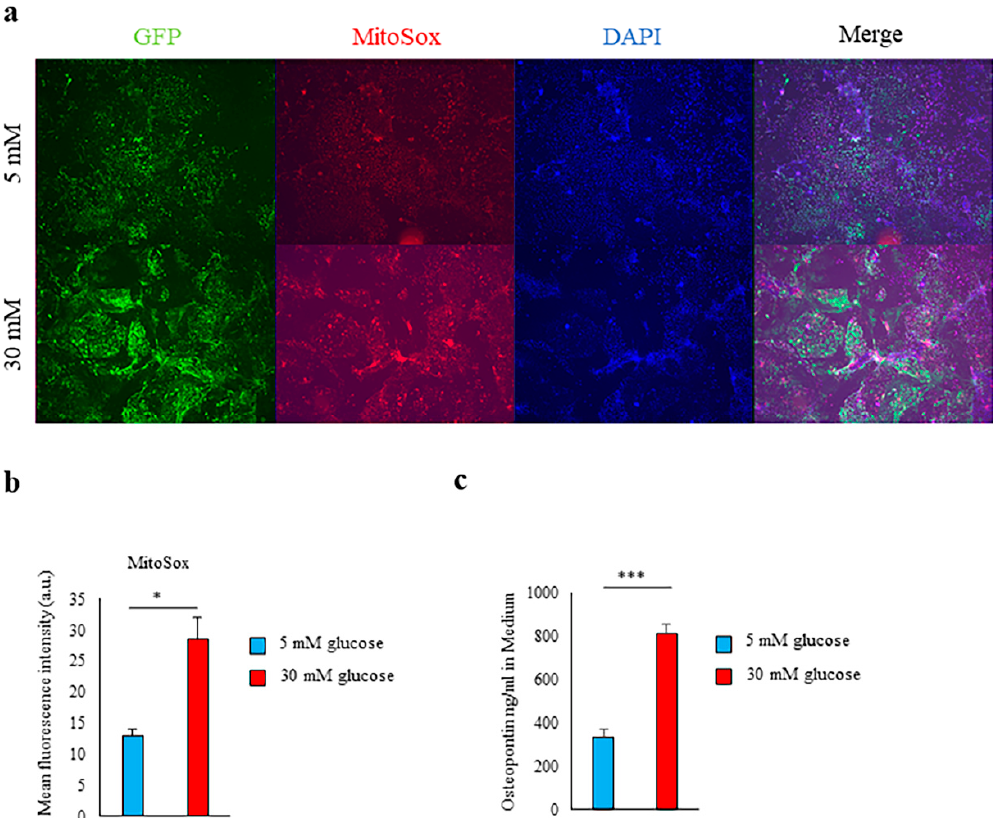
Figure 1. Hyperglycemia induced Spp1 transcriptional activity in renal proximal tubular epithelial cells. ( a–c ) Primary culture of proximal tubular epithelial cells (PTEC) derived from enhanced green fluorescent protein (EGFP)- Spp1 knock-in reporter mice. PTEC were cultured in 5 mM or 30 mM glucose conditions for 7 days. ( a ) Microscopic analysis of fluorescence of 4 (cid:48) ,6-diamidino-2-phenylindole (DAPI) and MitoSOX staining and of EGFP- Spp1 expression. ( b ) Mean fluorescence intensity of MitoSox in PTEC ( n = 3 per group). ( c ) Osteopontin (OPN) in the culture supernatants was assessed by enzyme-linked immunosorbent assay (ELISA; n = 6 per group). Data are shown as means, and error bars depict SEM. * p < 0.05, *** p < 0.001.